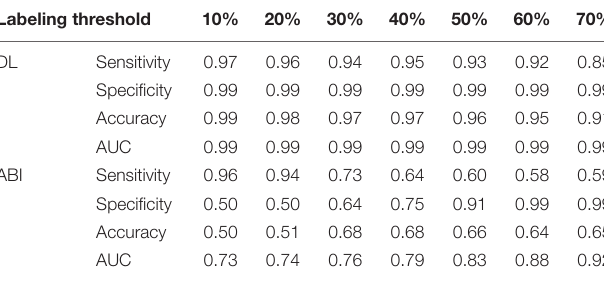
TABLE 1 | PAD detection performance of the deep learning-based pulse waveform analysis approach and ankle-brachial index, both corresponding to varying PAD severity threshold levels for labeling of healthy subjects and PAD